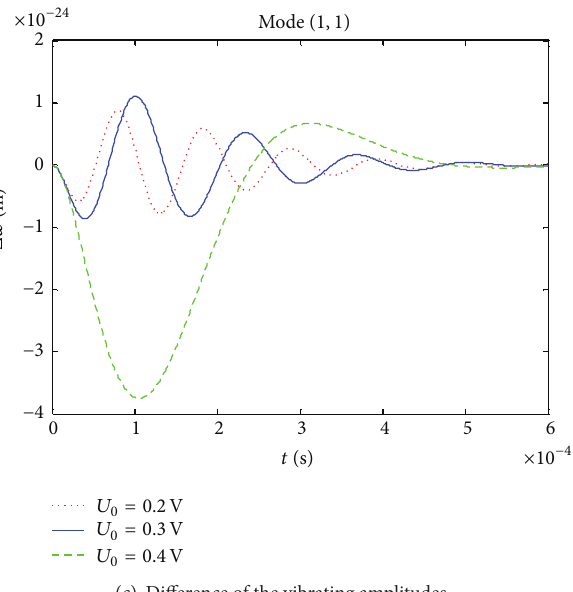
frequencies and vibration amplitudes of the micro resonant pressure sensor are investigated. Results show the